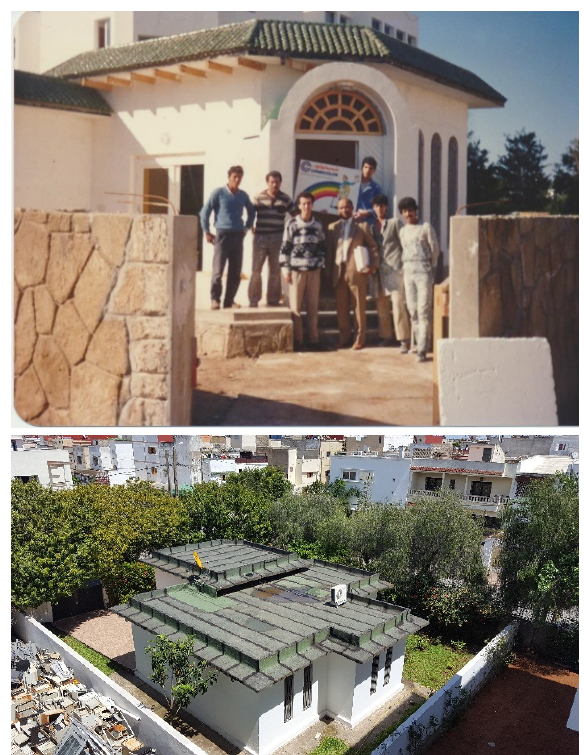
Figure 2. Experimental house made with gypsum mortar (beton Banché) (Courtsey; M. Sonebi, 1989 and 2018). Gypsum was used with dune sand for the manufacture of